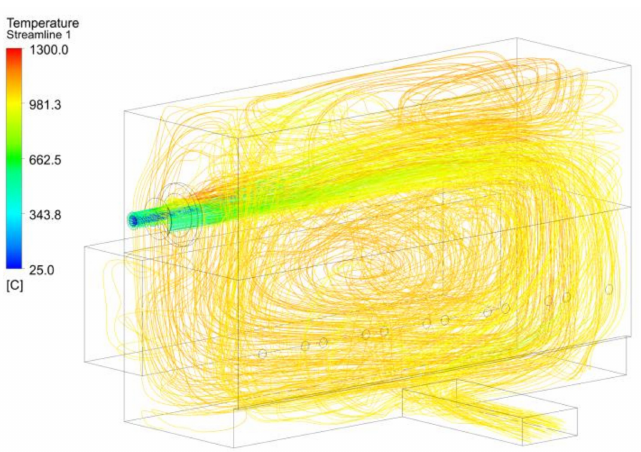
Figure 16. Temperature streamlines for the BFG 1